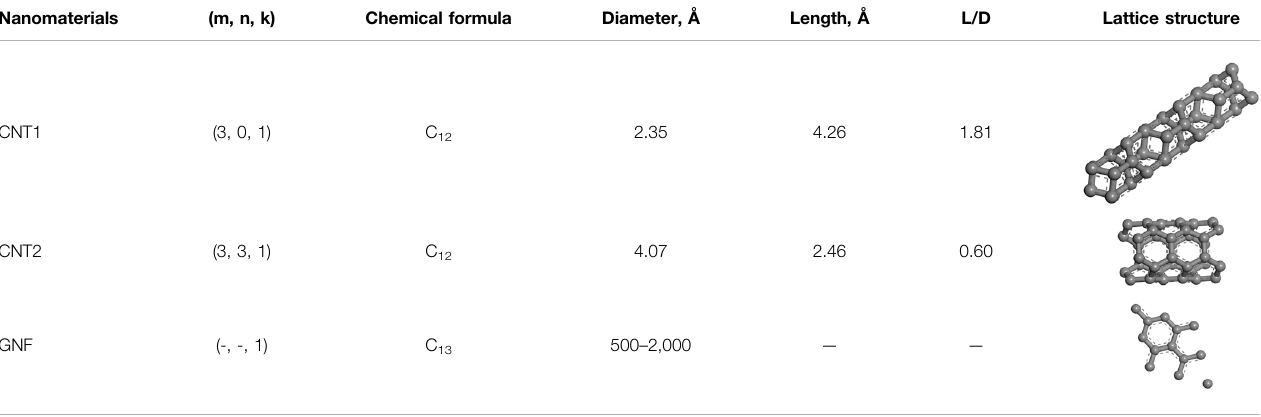
TABLE 2 | Lattice structure and physical properties of the carbon-based nanomaterials.